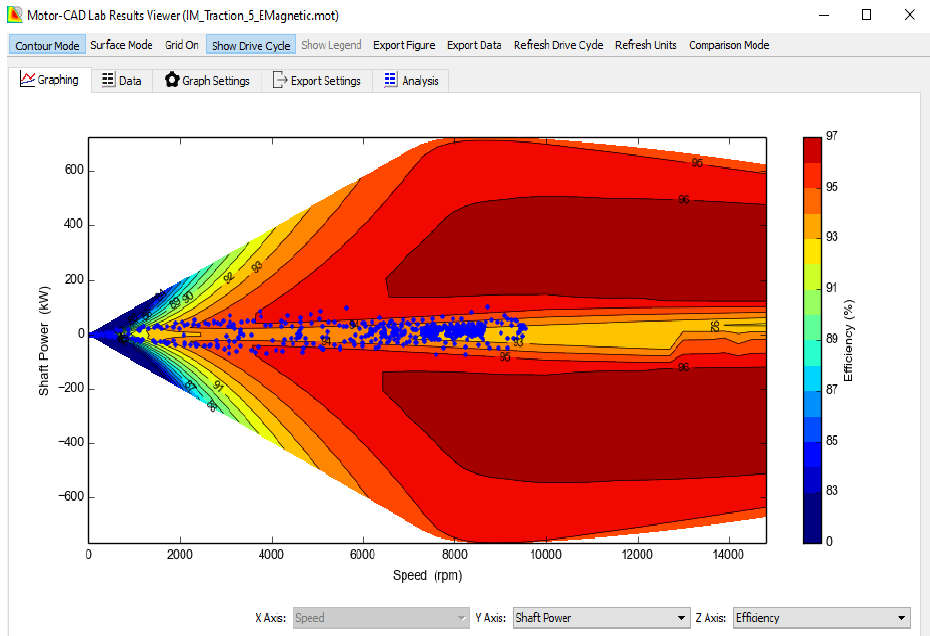
Figure 10. Shaft Power of Designed